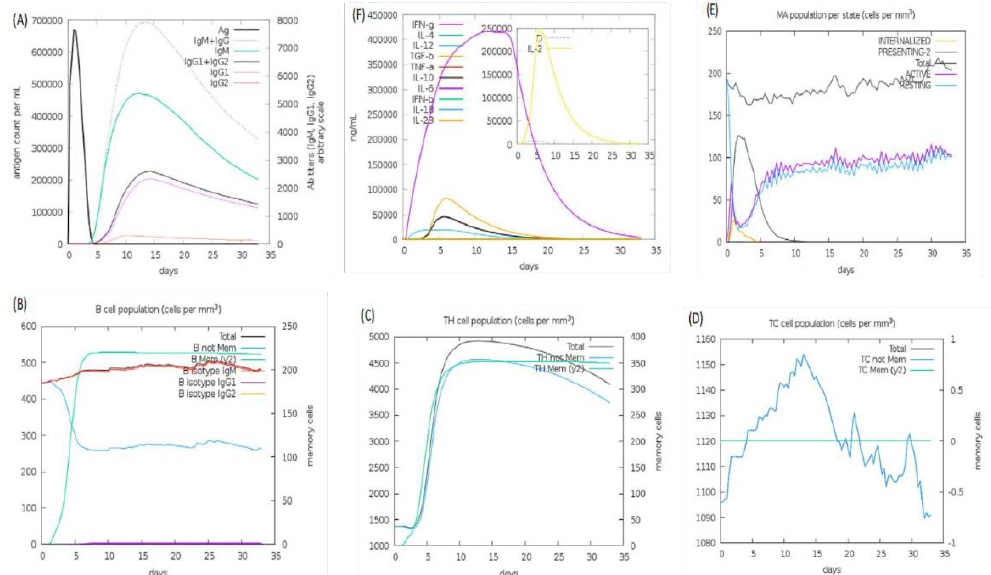
Figure 10. Immune simulations: panel ( A ) shows the number of immunoglobulin reactions per milliliter of antigen, panel ( B ) shows the count of B lymphocytes, panel ( C ) shows the count of CD4 T-cells, panel ( D ) shows the count of CD8 T-cells, panel ( E ) shows the macrophages and the amount of internalized pathogens, and panel ( F ) shows the secretion concentrations of cytokines and interleukins.